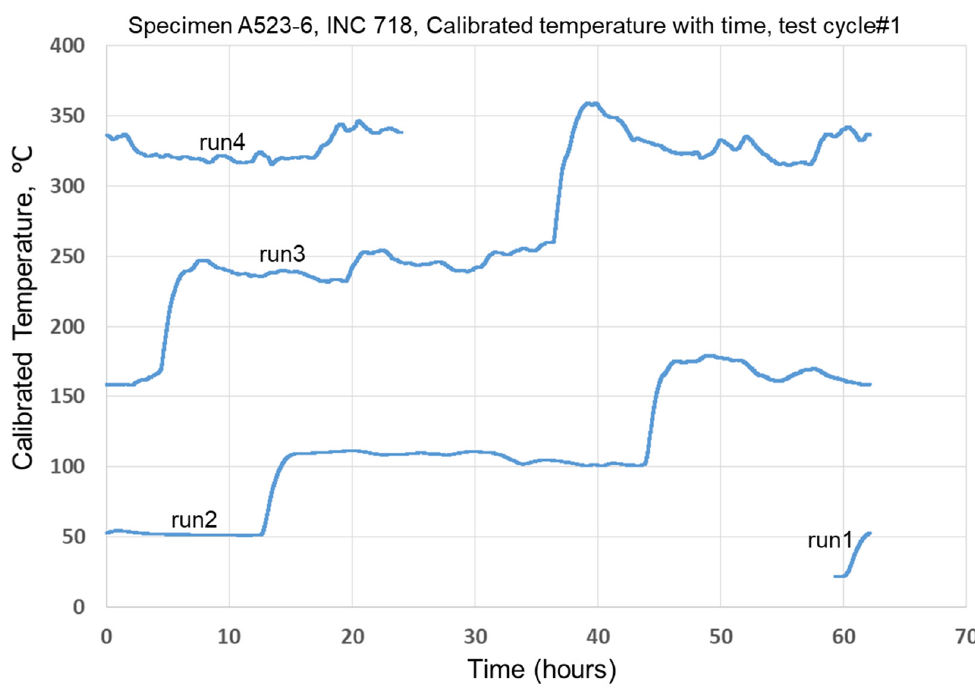
Figure 14. Calibrated temperature measurement using embedded FBG sensor on INC 718 specimen A523-6 (test cycle#1).